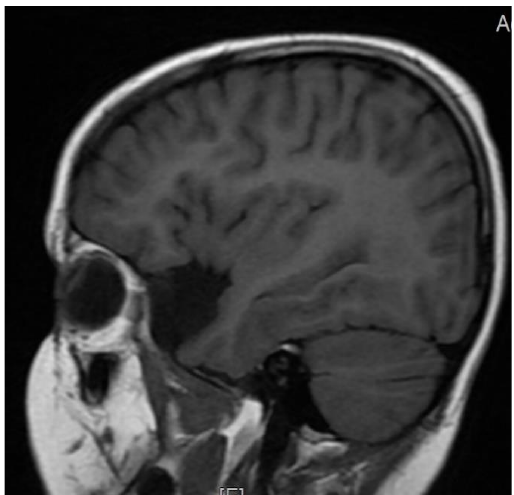
Figure 3. T1-weighted sequence. Cyst modeling temporal lobe.